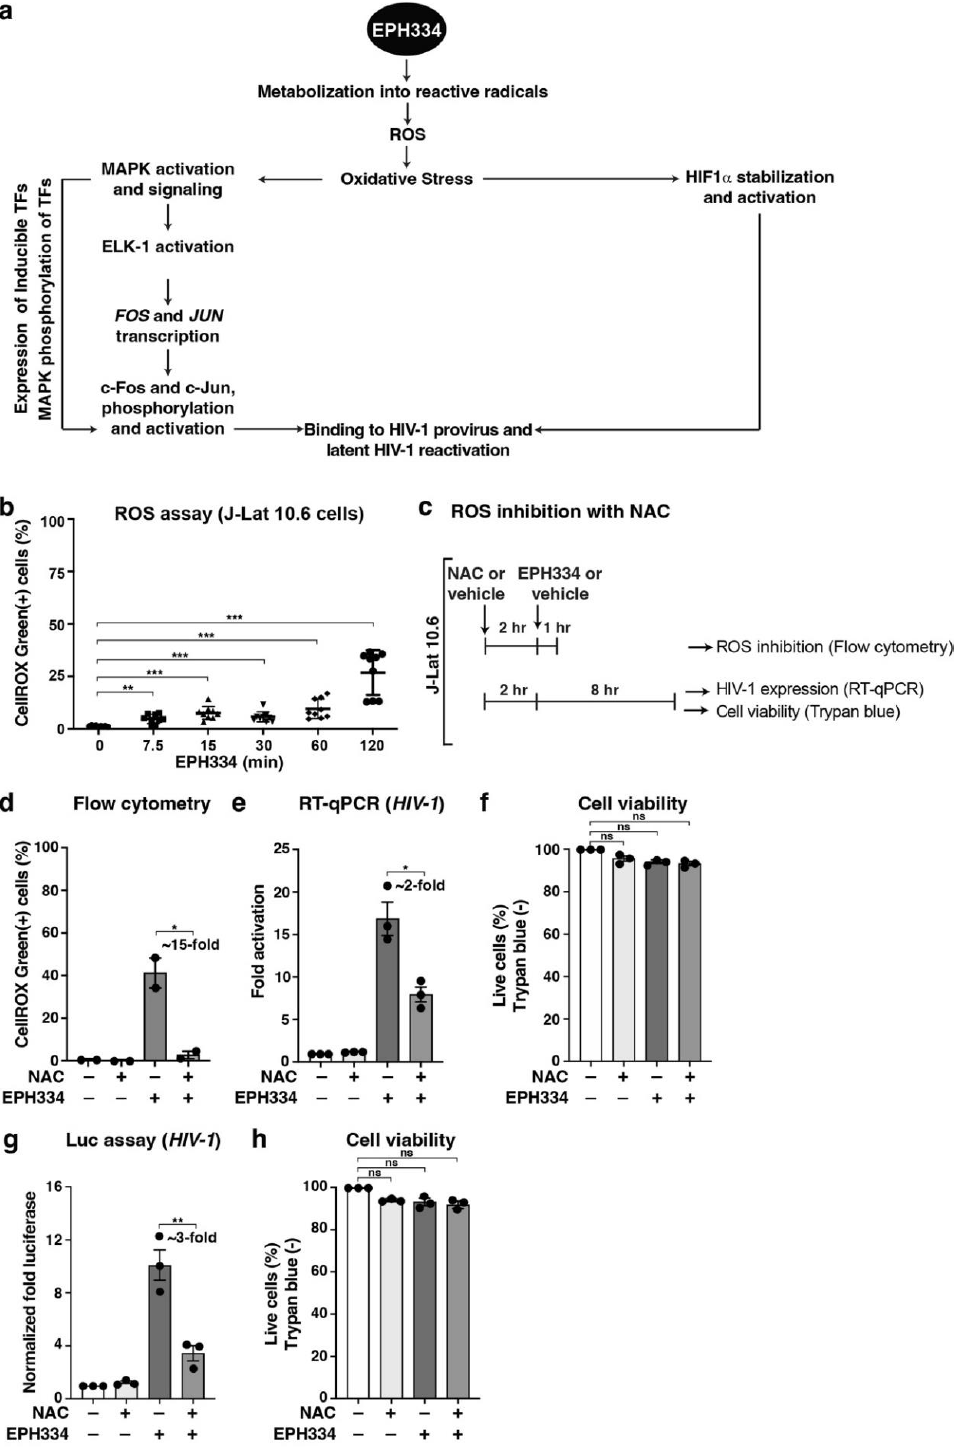
Figure 4. EPH334 triggers oxidative stress to reactivate latent HIV-1. ( a ) Transcriptome-based model predicting EPH334 elicits oxidative stress, thereby inducing several redox-responsive programs